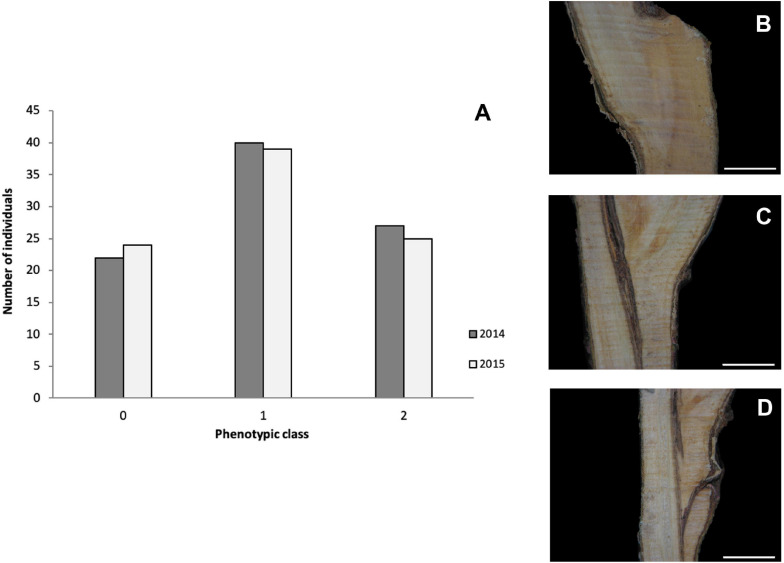
(A) Distribution of classified graft (in)compatibility phenotypic classes in the mapping population “Mo × Pa” progeny in the years 2014 and 2015. Images showing categories 0 (B), 1 (C), and 2 (D). Scale bars = 5 mm. Category descriptions: (0) perfect union in which the graft line is almost invisible; (1) the bark and wood are continuous, although the line of union in the wood is often clearly distinguished by excessive ray formation; and (2) unions showing vascular and wood discontinuities.